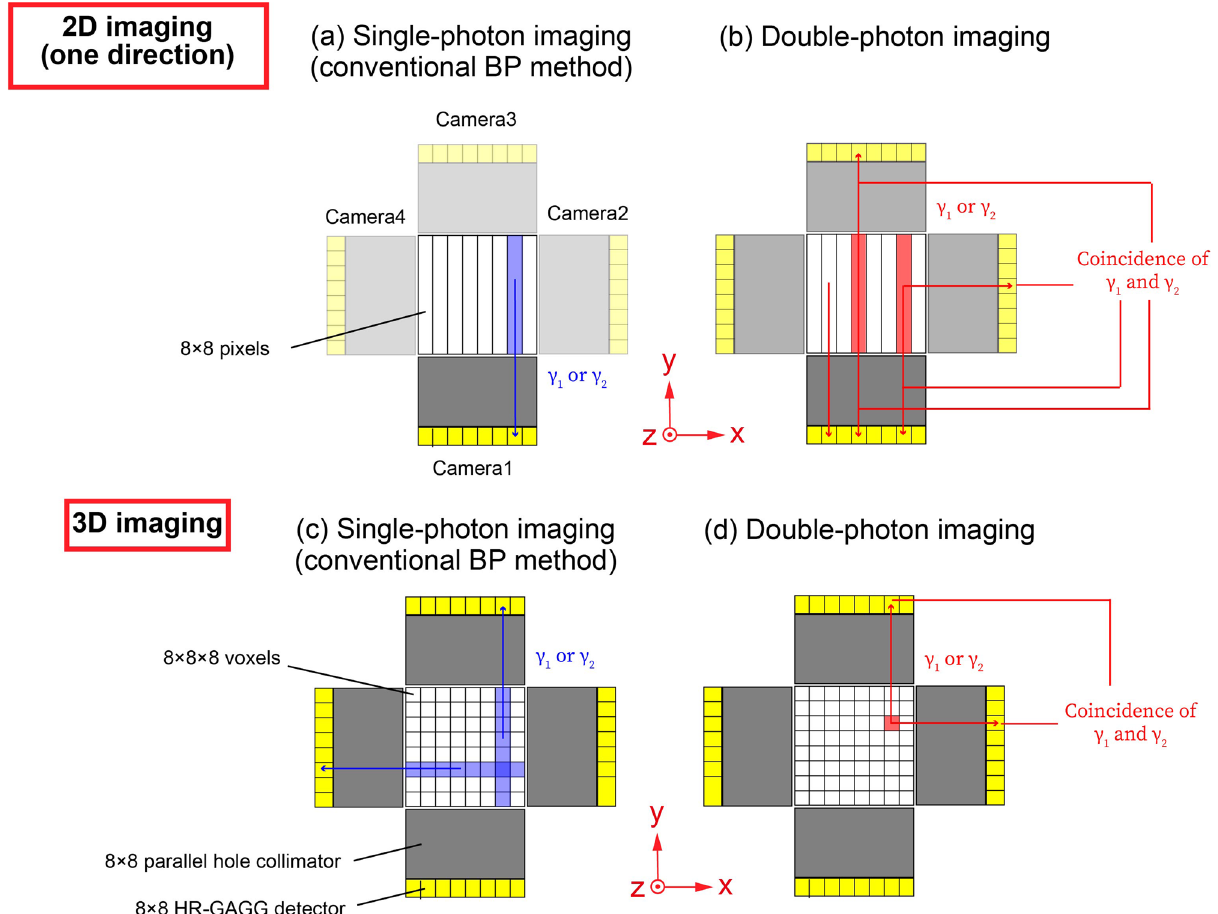
Figure 7. Imaging methods. ( a ) The single-photon 2D imaging method. ( b ) The double-photon 2D imaging method. The 2D imaging in one direction provides an image in the x – z plane with 8 × 8 px. The coincidence events between cameras 1 and 2, 3, or 4 are used for the double-photon coincidence 2D imaging. ( c ) The single- photon 3D imaging method. The back projection (BP) method is used for single-photon 3D imaging. Eight voxels in the x – y plane are incremented by 1/8 from two directions. (d) The double-photon 3D imaging method. The coincidence events of 90° are used for double-photon 3D imaging. A voxel determined by an intersection of the coincidence event directions is increased by 1. This figure was created using the software (Adobe Illustrator, Illustrator CC 24, https:// www. adobe. com/ produ cts/ illus trator.